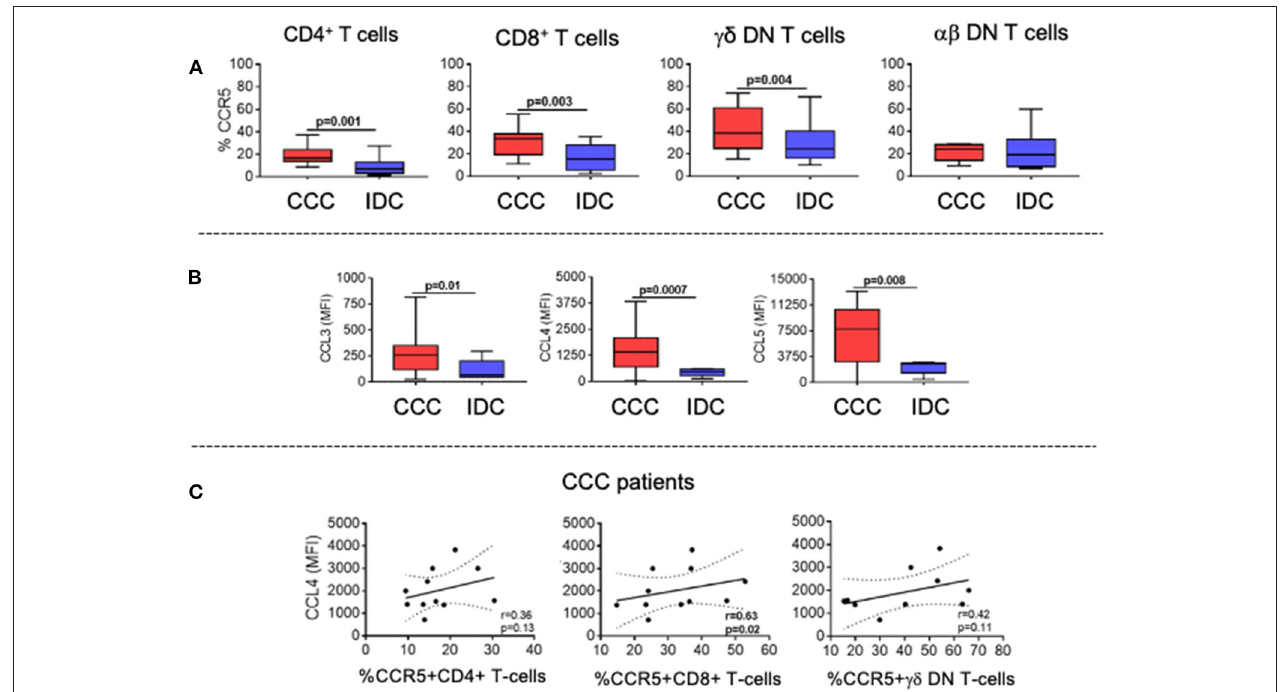
FIGURE 5 | Expression of CCR5 by the different T-cell subpopulations and of its soluble chemokine ligands CCL3, CCL4, CCL5. (A) Evaluation of the frequency of expression of CCR5 by CD4 + , CD8 + , gamma-delta + DN T cells (CCC, n = 17, IDC, n = 13) and alpha-beta+ DN T cells (CCC, n = 10, IDC, n = 10). The analysis was performed as described in the materials and methods for comparison between the different groups. (B) Plasma levels of soluble chemokines (CCL3, CCL4, CCL5) in samples from patients with Chronic Chagas cardiomyopathy (CCC, n = 38) and idiopathic cardiomyopathy (IDC, n = 5). Graphs are expressed as boxplots, with the minimum and maximum values indicated. (C) Correlation analysis between plasma levels of CCL4 and the frequency of expression of CCR5 in CD4 + , CD8 + and gamma-delta + DN T cells in CCC group. Parametric data were analyzed using Pearson’s correlation test and non-parametric data using Spearman’s test. Values of p < 0.05 were considered statistically